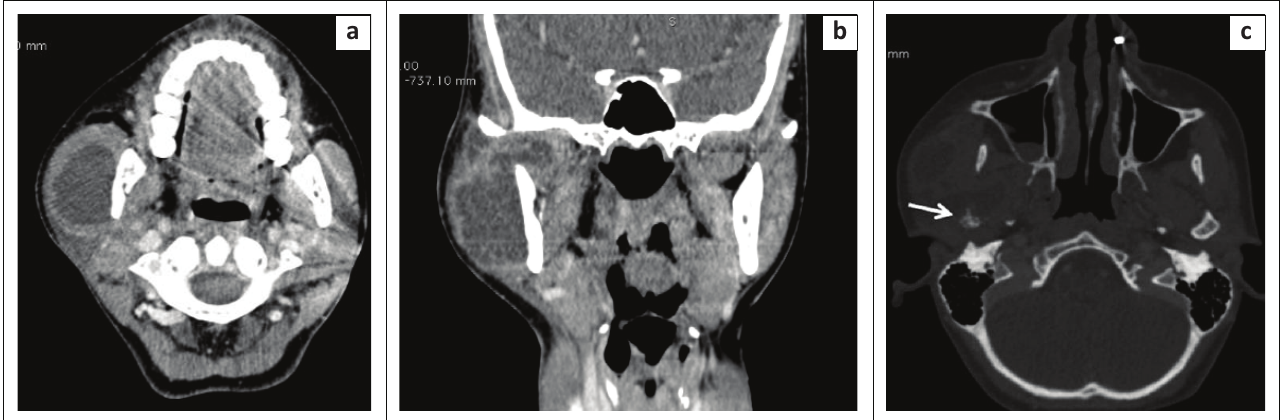
FIGURE 2: A 23-year-old female with swelling in the right parotid region. Post-contrast axial (a) and coronal (b) computed tomography images demonstrate a hypodense collection in the right masseter extending into the temporo-mandibular joint. Axial computed tomography bone window image (c) shows the involvement of the right mandibular condyle with partial lysis of the bone and cortical erosion (white arrow).